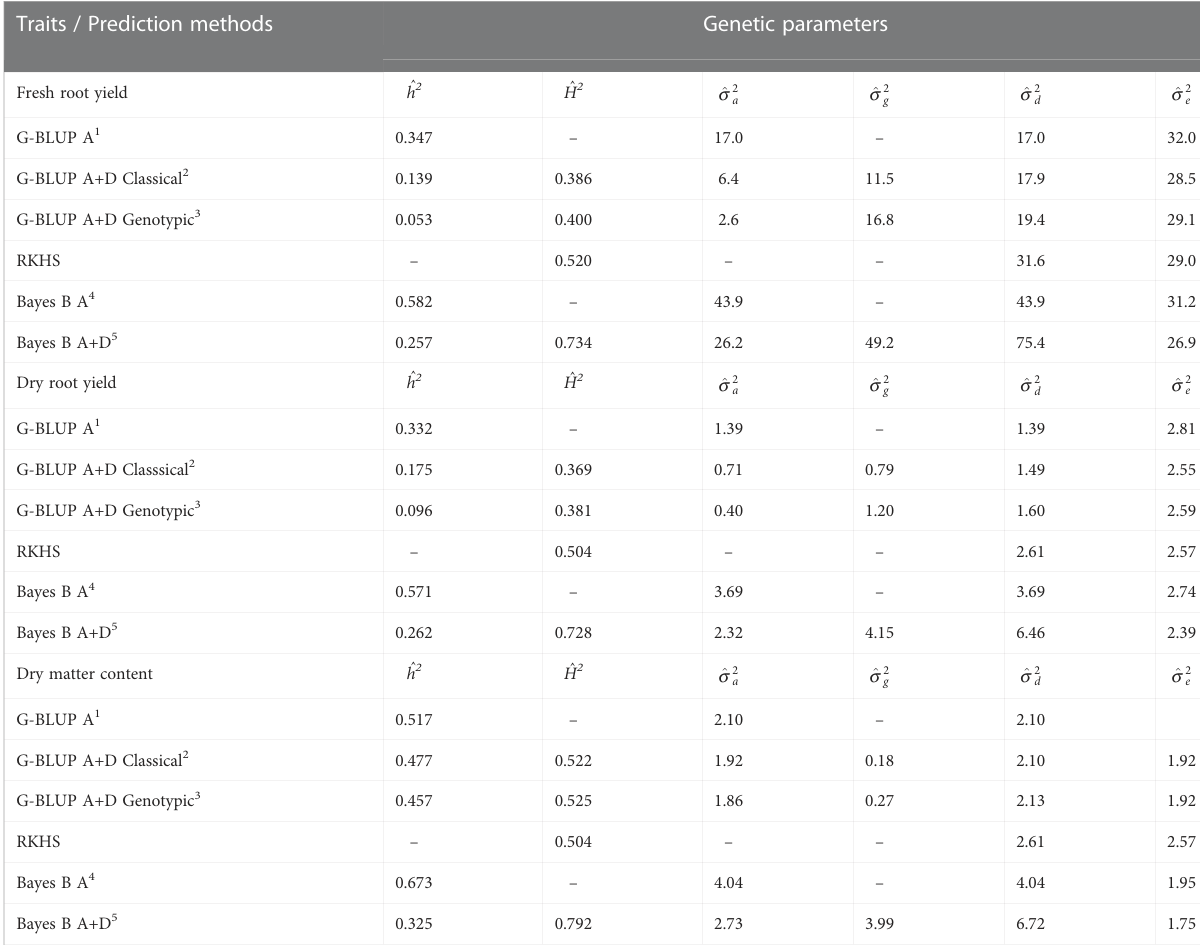
TABLE 1 Means of the genetic parameters estimated by different genomic prediction methods for fresh root yield (FRY), dry root yield (DRY), and dry matter content (DMC) in roots of cassava. Traits / Prediction